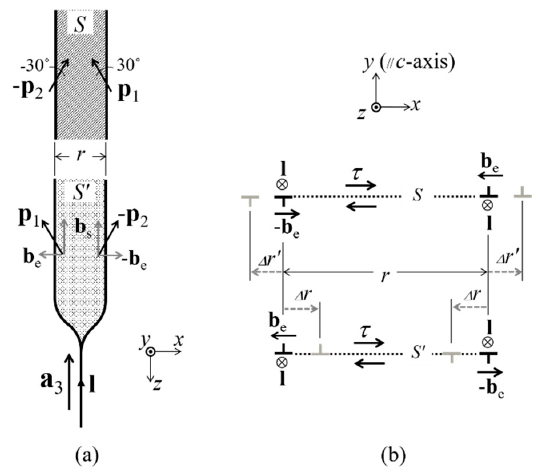
Figure 6. Separation changes of an extended screw dislocation under an applied shear stress. ( a ) Burgers vectors of Shockley partials on the basal planes S ′ and S (see Figure 4b,c). The z -axis is parallel to the line sense l , whereas y is normal to the basal plane. The vectors b e and b s are the edge and screw components of the Burgers vector p 1 of the Shockley partial. ( b ) The arrangement of edge components, viewed parallel to the z -axis. The applied shear stress τ exerts a force τ b e on the dislocations, causing the two partials to move apart by 2 Δ r ′ on S ′ , but to move closer by 2 Δ r on S .